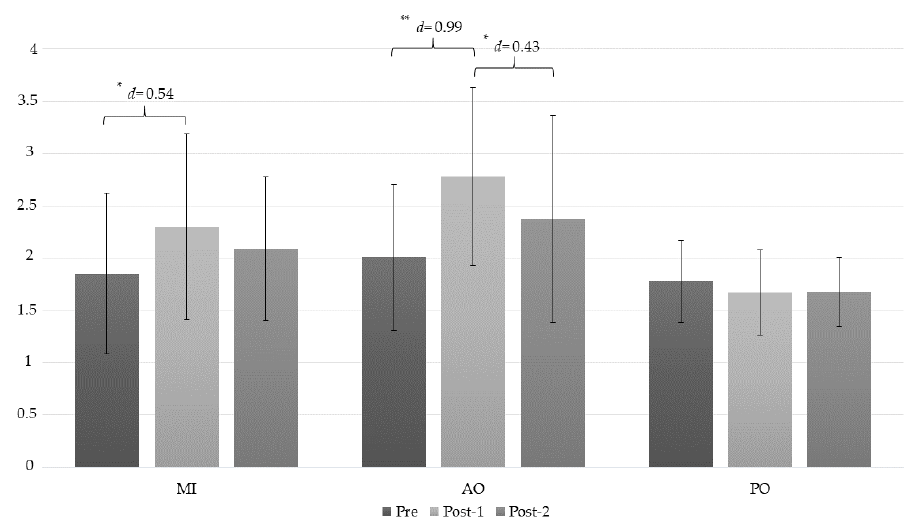
Figure 5. Changes in the PPT left trapezius measurement. *: p < 0.05; **: p < 0.001; AO: action observation; MI: motor imagery group; PO: placebo observation group; Pre: pre-intervention measurement; Post-1: first post intervention measurement (immediately after intervention); Post-2: second post intervention measurement (10 min after intervention).